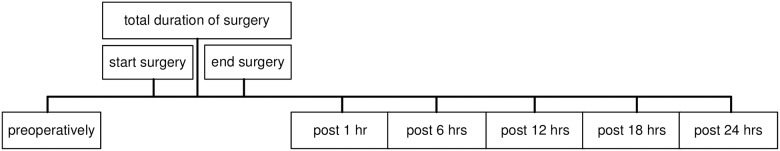
Epochs for analysis.